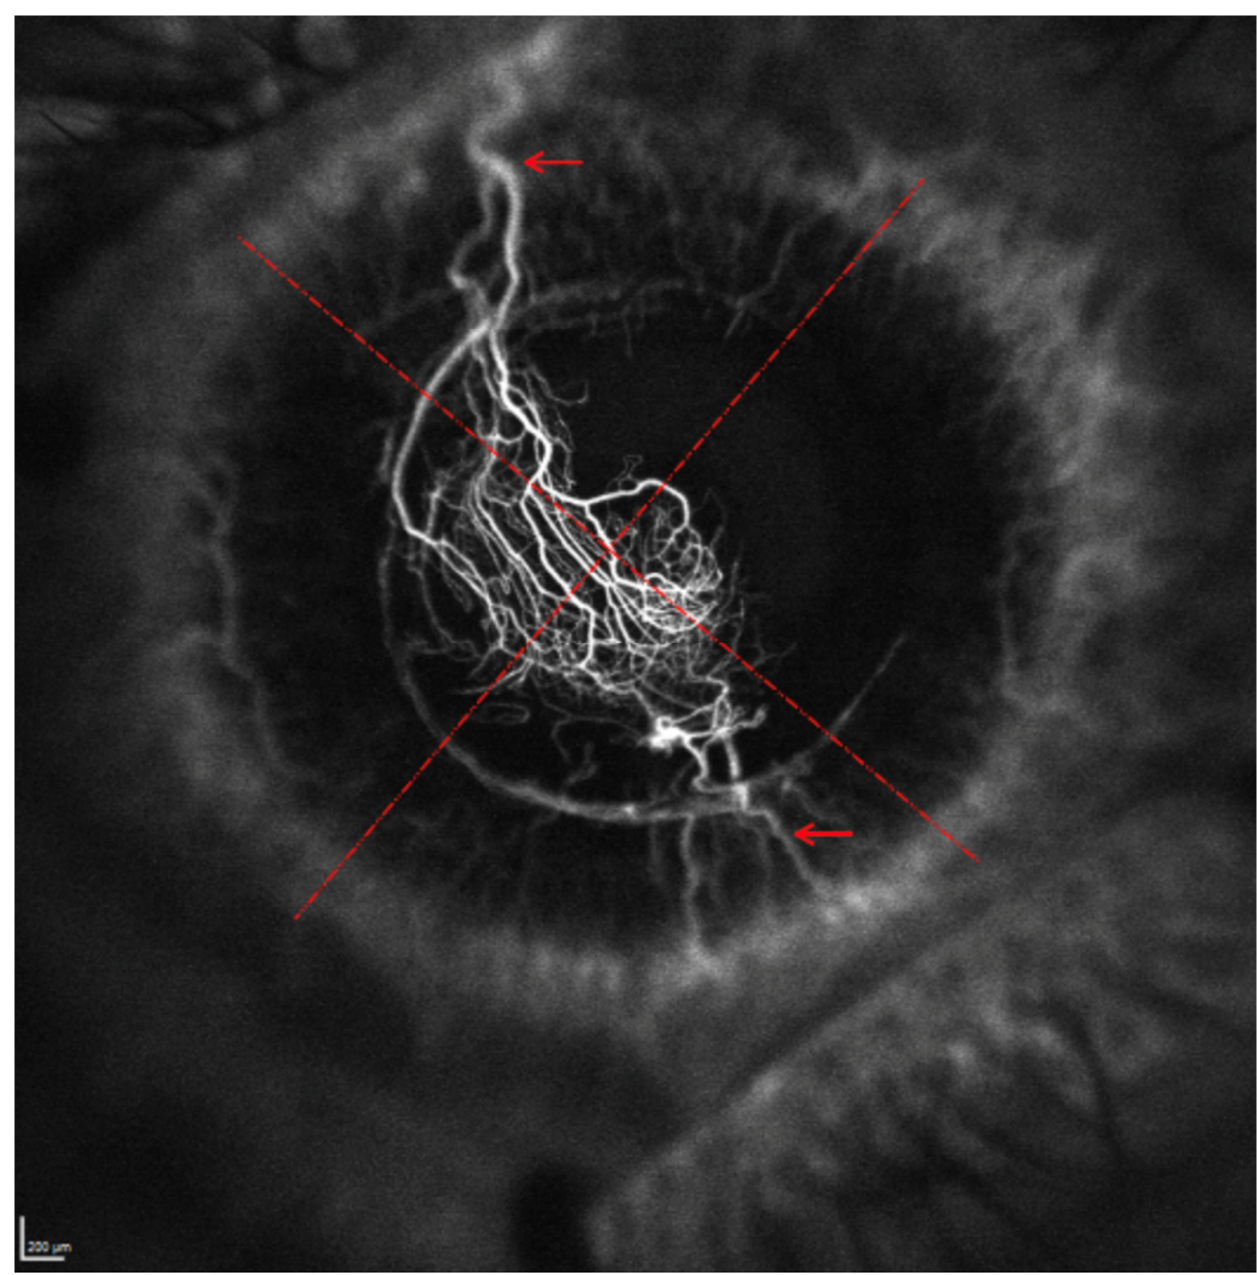
Figure 1. Division of cornea into four quadrants with a super-imposed cross image (dashed). The origin of the ConV is highlighted by arrows.